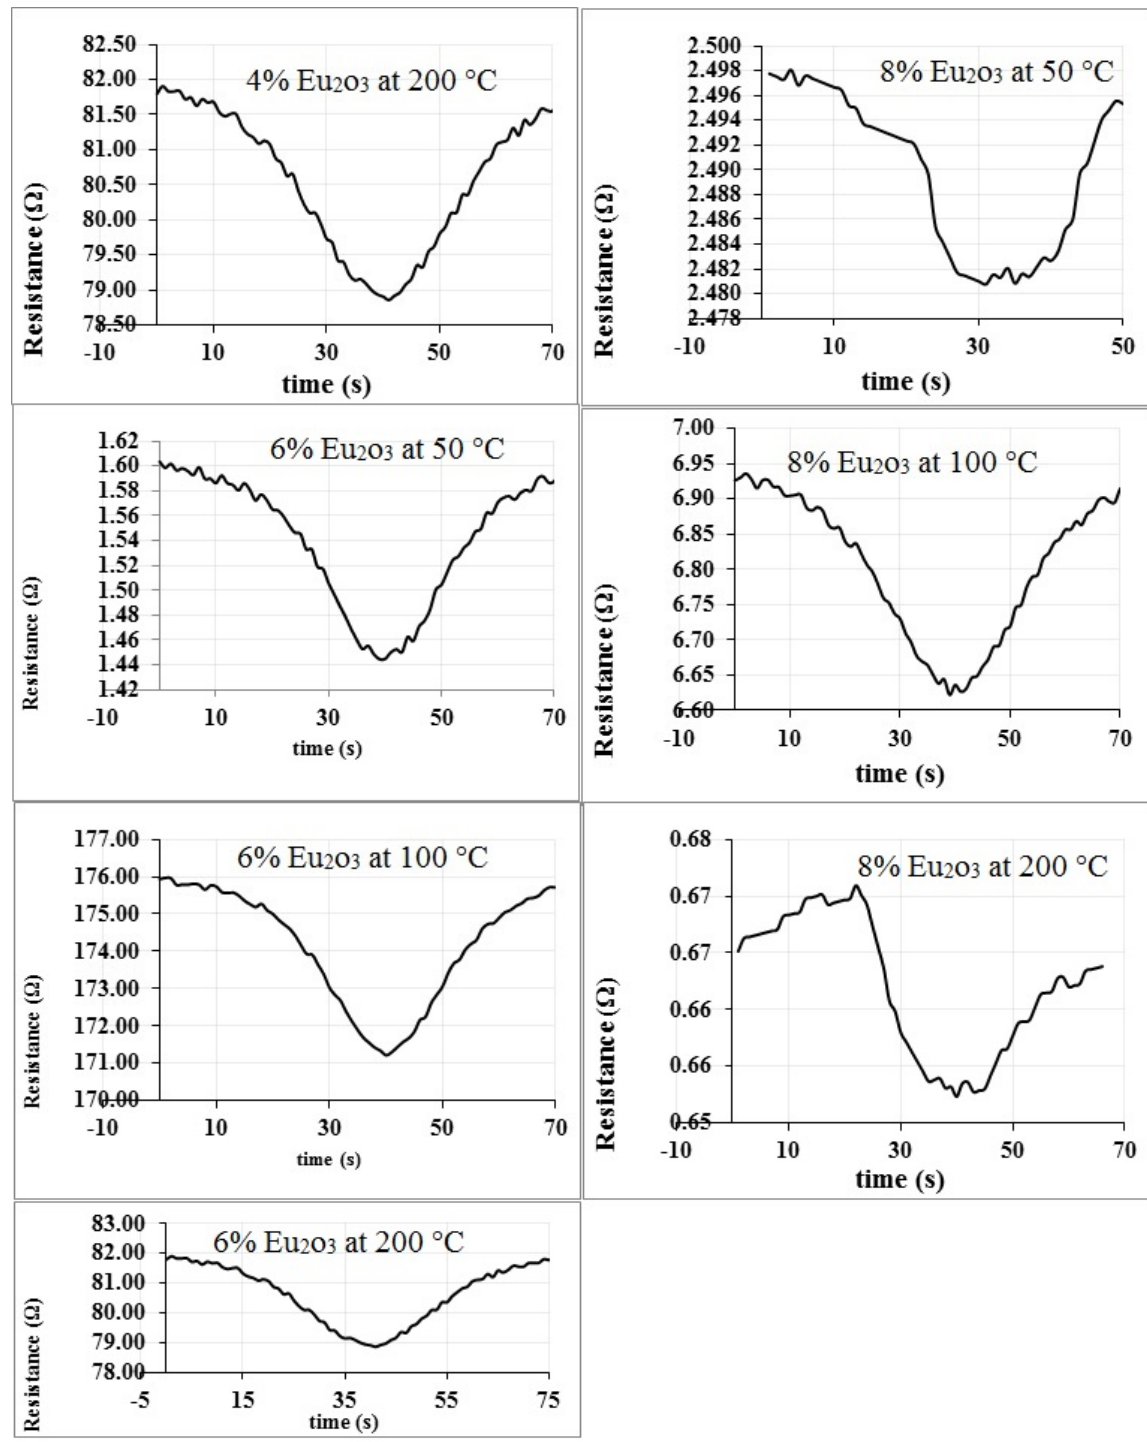
Fig.6: The variation of resistance as a function to the time for V and 8) wt %. Eu